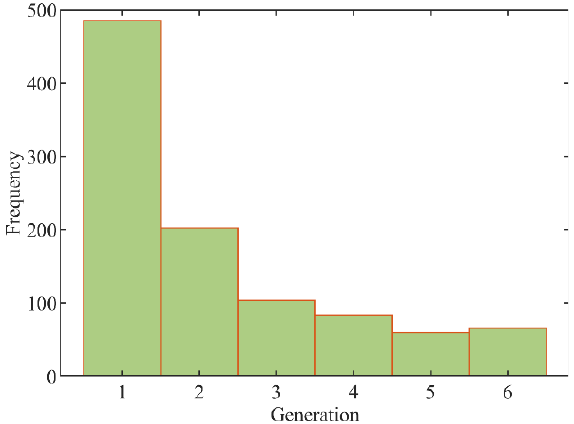
Figure 10. Statistical graph of convergence times.